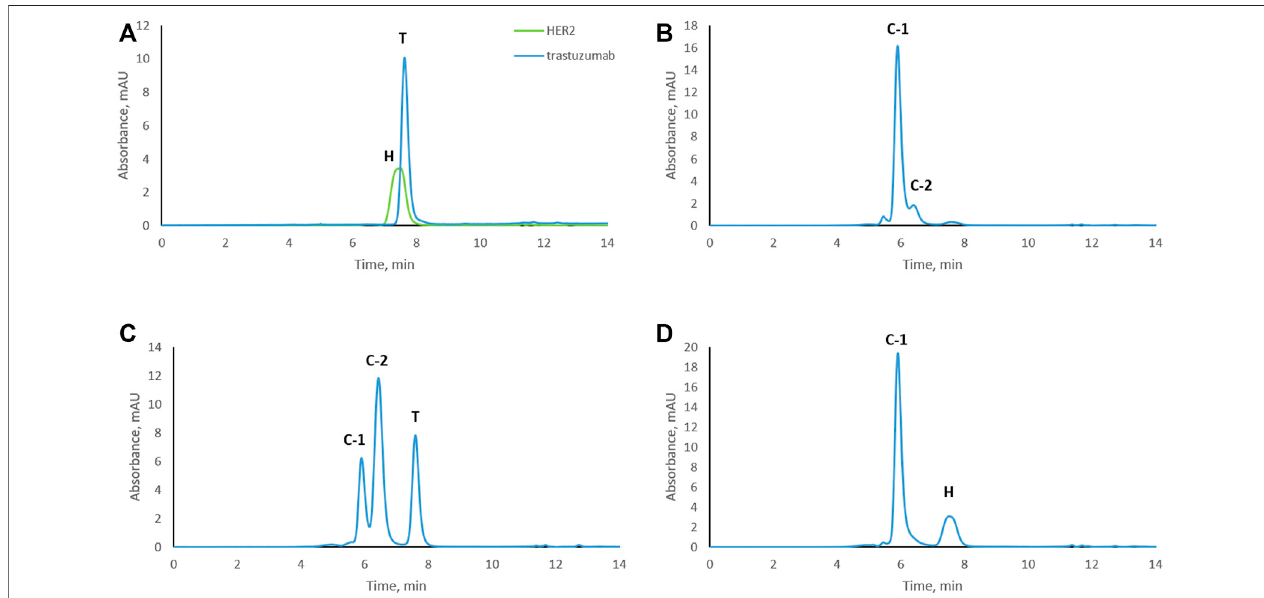
FIGURE 1 | Size-exclusion chromatograms of trastuzumab – HER2 complexes formed at different molar ratios. (A) Overlay chromatograms of trastuzumab and HER2. (B) Complex formed at 1:1 molar ratio. (C) Complex formed at 2:1 molar ratio (excess of trastuzumab). (D) Complex formed at 1:2 molar ratio (excess of HER2). C-1, complex-1 at 5.9 min; C-2, complex-2 at 6.4 min; T, trastuzumab at 7.7 min; H, HER2 at 7.5 min. UV absorbance was measured at 280 nm.